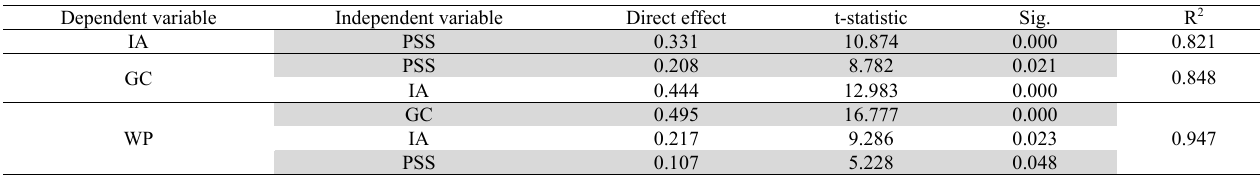
The results of direct